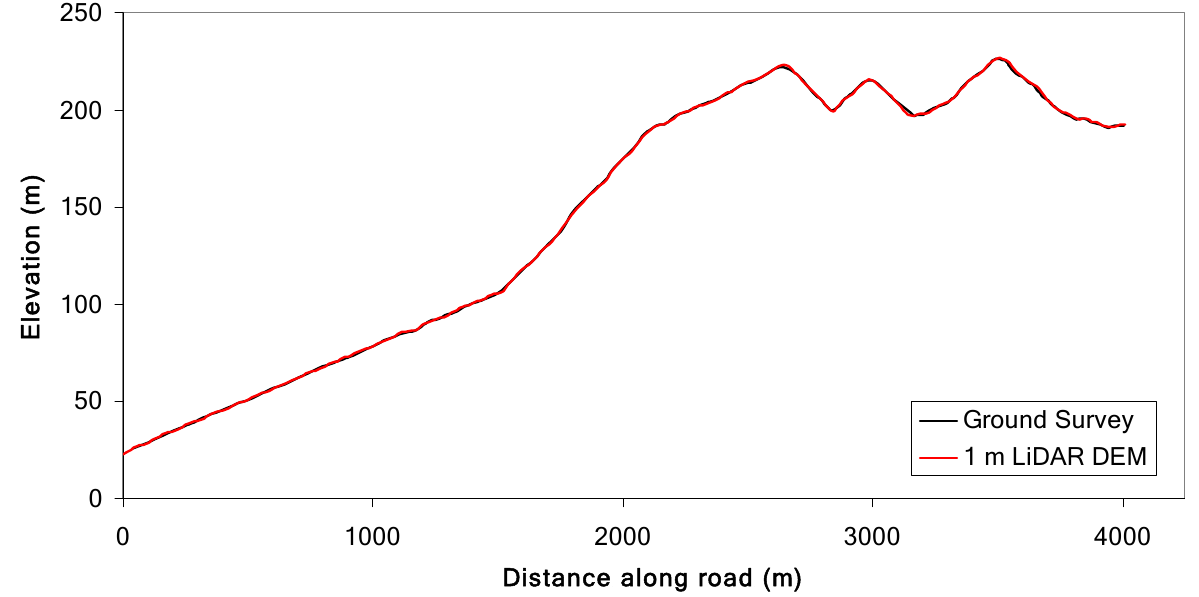
Figure 11. Longitudinal profiles derived from ground survey and LiDAR